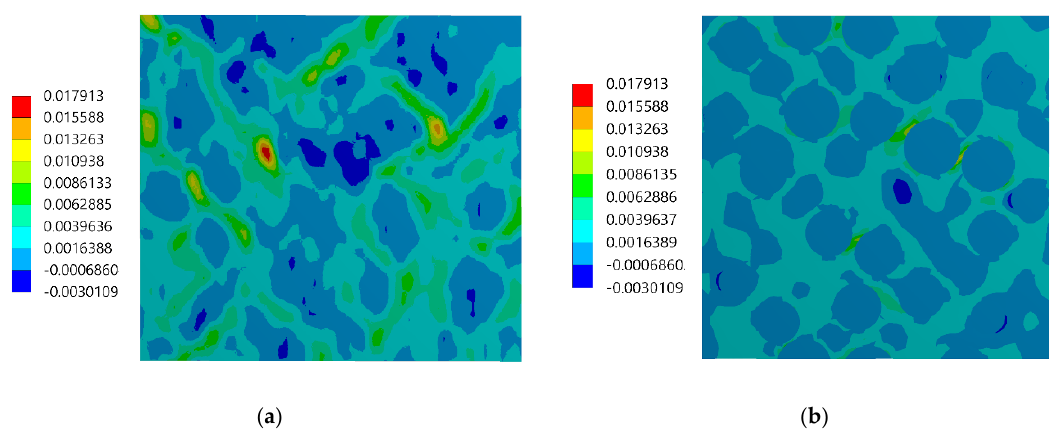
Figure 13. Strain ε xx distributions: ( a ) experimental results (DIC), ( b ) numerical results (FEM).